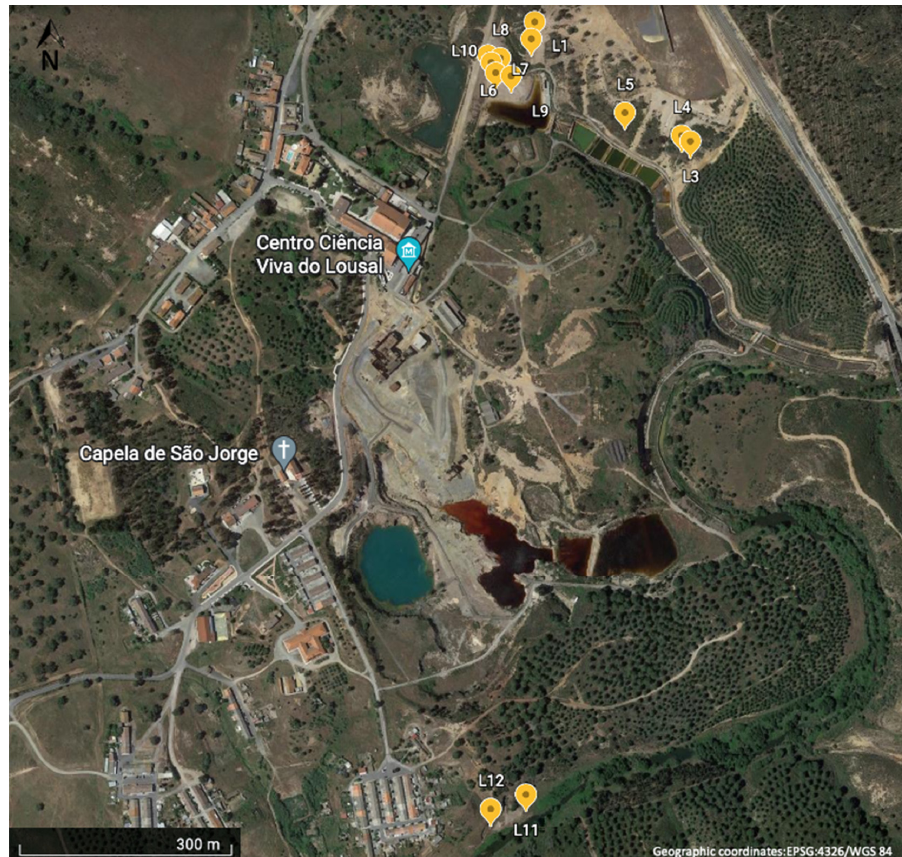
Figure 3. Google Earth image (24 May 2022) evidencing the sampling sites at the Lousal mine area. L1–L5: area potentially affected by acid mine drainage from old tailing deposits; L6–L10; area potentially affected from the pyrite road and railway transport network; and L11–L12: sampling points near the exit of an old mine gallery, with tailing